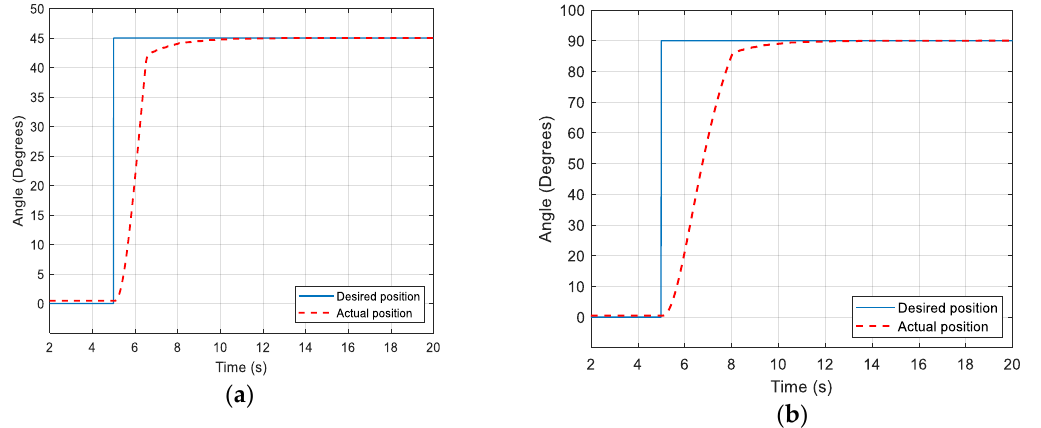
Figure 11. Simulated actual and desired positions of the soft finger with a step driven input. (a) The step input from 0˚ to 45˚. (b) The step input from 0˚ to 90˚.